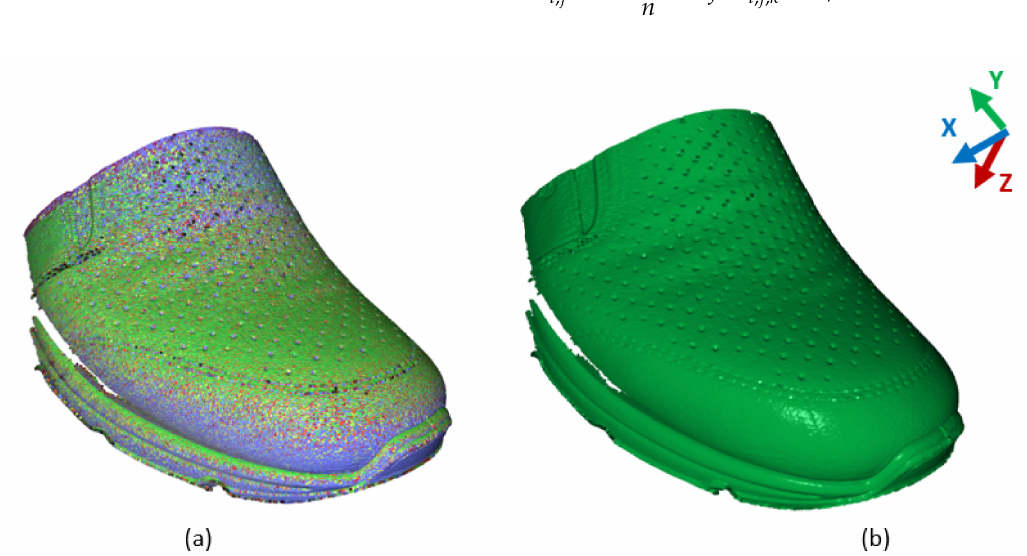
Figure 11. Scans of correct placed ( a ) and generated etalon scan ( b